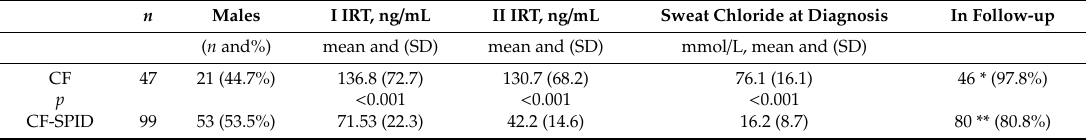
Table 1. Newborn screening of cystic fibrosis (CF) and CF-screening positive inconclusive diagnosis (CF-SPID)